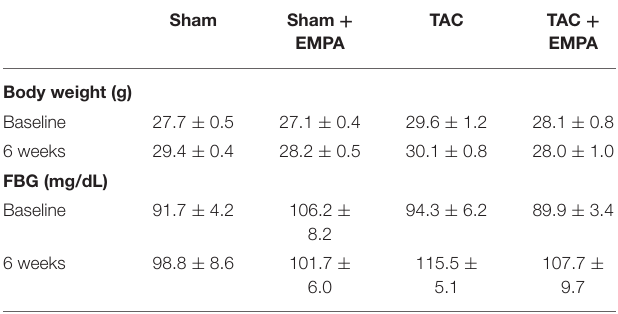
TABLE 2 | Body weight and fasting blood glucose in different groups.